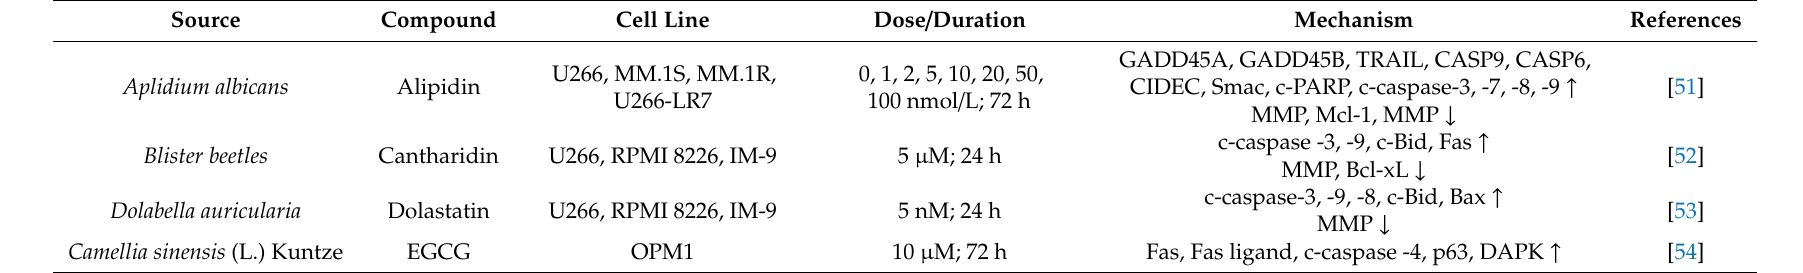
Table 3. Intrinsic and Extrinsic pathway apoptosis inducing natural